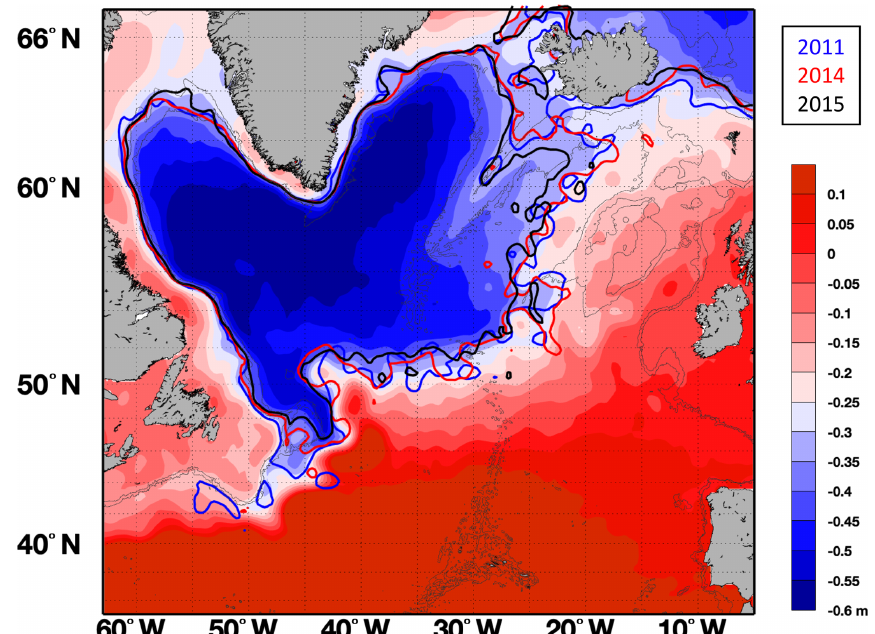
Figure A1. Time-mean SSH of the subpolar gyre (1993–2015) with a contour interval of 5cm. Contours in color indicate the subpolar gyre boundaries in January 2011, 2014 and 2015 defined with the 1cm contour intervals of the monthly SSH field.